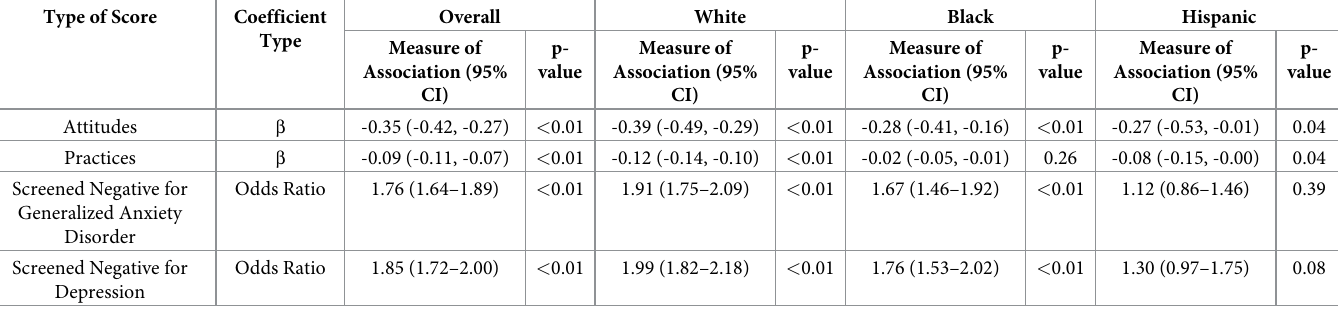
Table 3. Association of SDOH scores with attitudes, practices and mental health outcomes among Arkansans overall and by race and ethnicity a,b,c,d